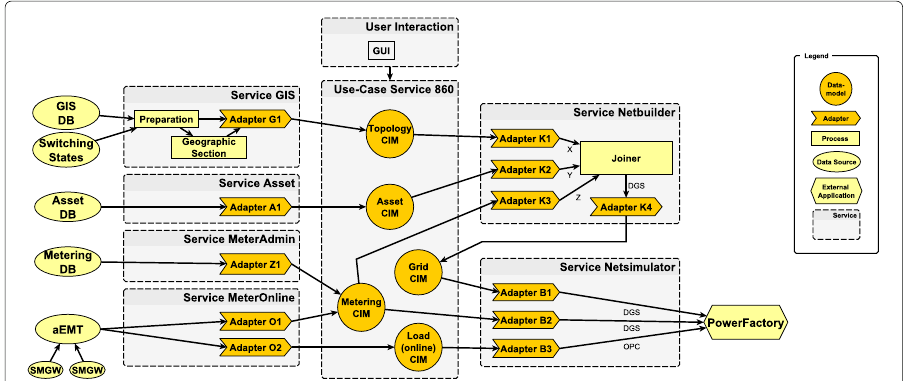
Fig. 6 Implementation of the scenario “Data acquisition for network calculation” by means of a central use-case service, which coordinates the specialized application services